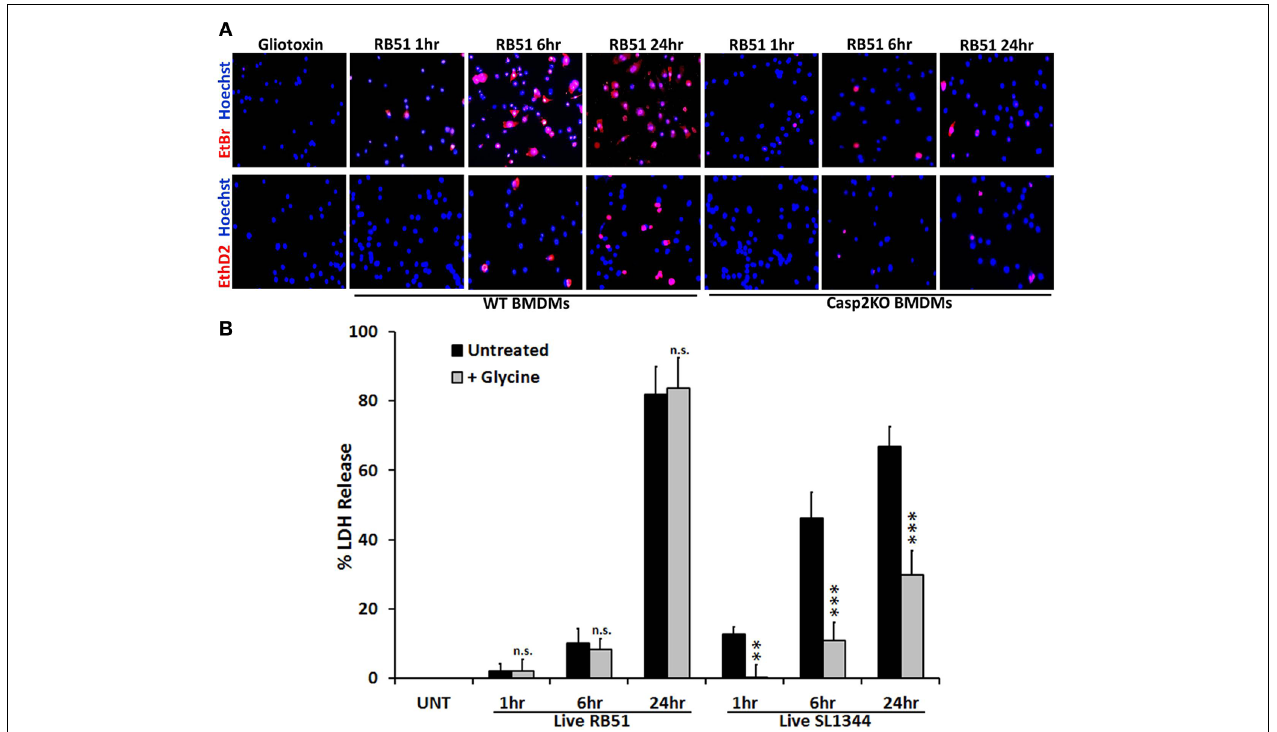
FIGURE 3 | Pore formation does not contribute to RB51-induced cell death. (A) WT and casp2 − / − BMDMs treated with Gliotoxin (10 μ M, 6h treatment) or infected with RB51 were stained with the membrane permeable dye Hoechst 33342 (blue) and the membrane impermeant dyes (red), EtBr (MW 394) or EthD2 (MW 1293). Adherent cells were visualized by